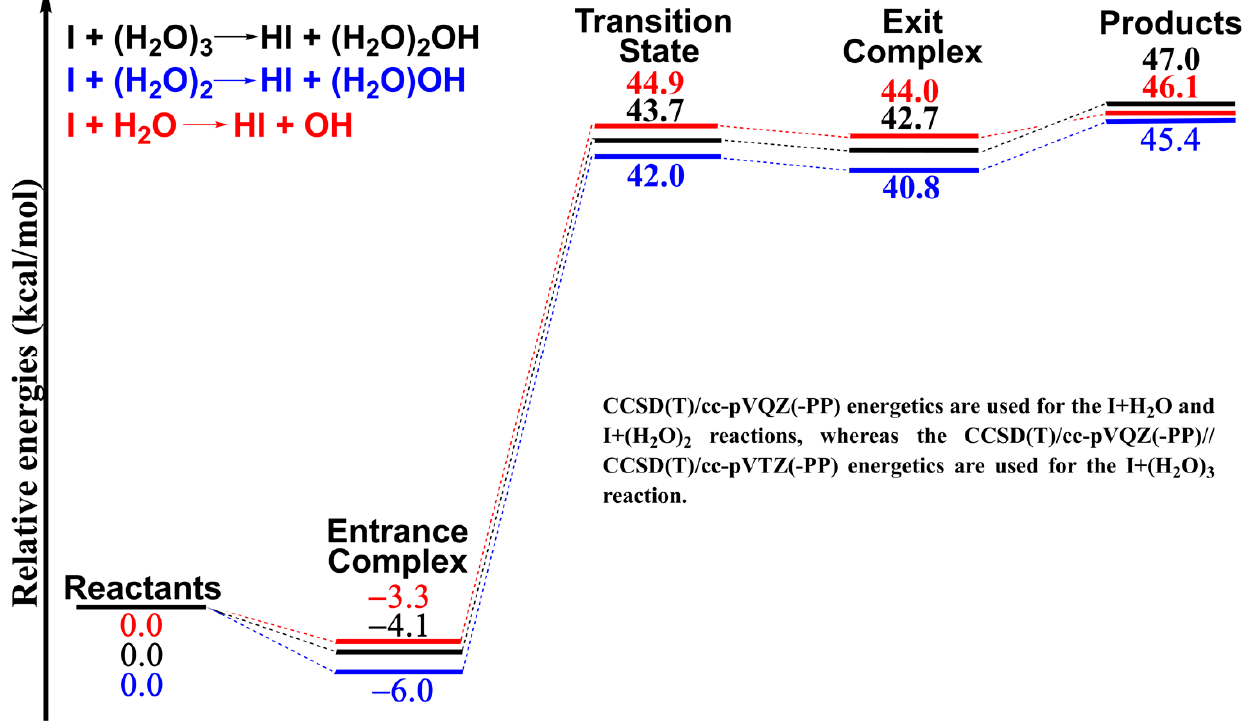
Figure 2. Comparison of the potential energy profiles for the I + (H 2 O) 3 , I + (H 2 O) 2 and I + H 2 O reactions.